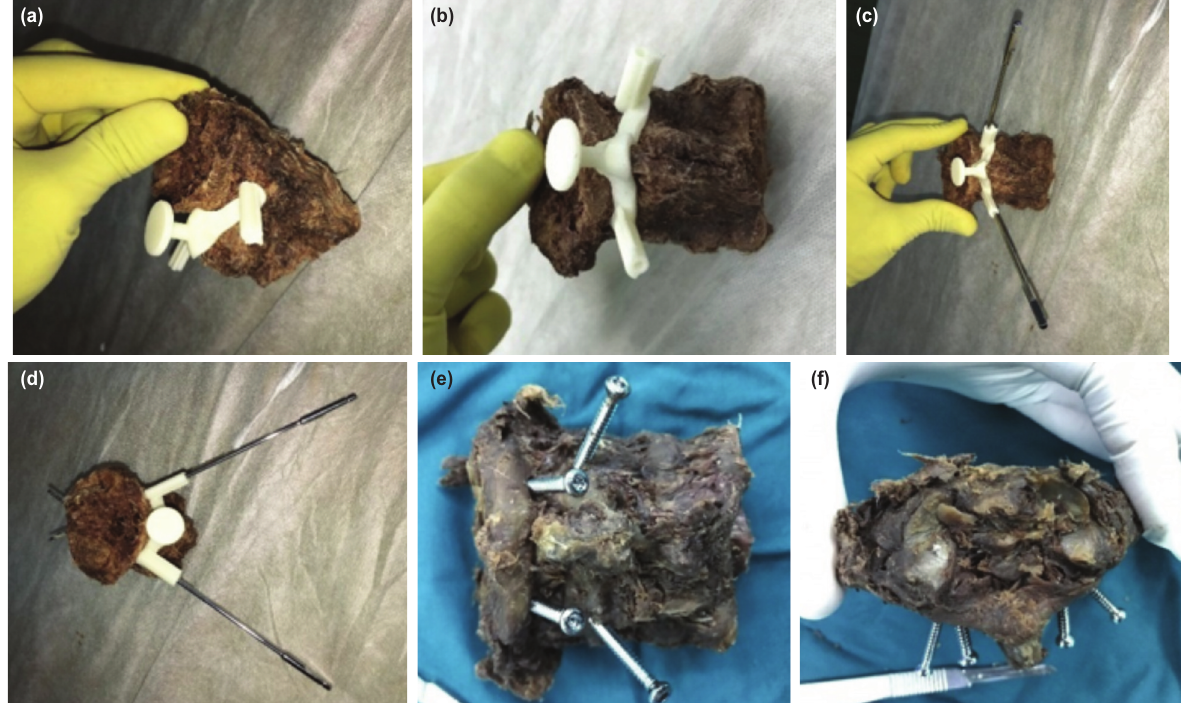
Stages of screw fixation and a screw- fixed sample. (a) The template fixed over the C2 vertebrae. (b) The template shown on the Fig. 7: sample from different angle. (c) The path drilled in the path. (d) Same sample from different angle. (e) The screws inserted after drilling. (f) Same sample shown with the fixed